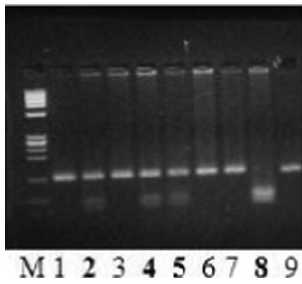
Figure 1 - Electrophoresis of PCR and RFLP – The lines 2, 4 and 5 indicate the heterozygous pattern. The line 8 represents the homozygous pattern and the M corresponds to the molecular weight marker